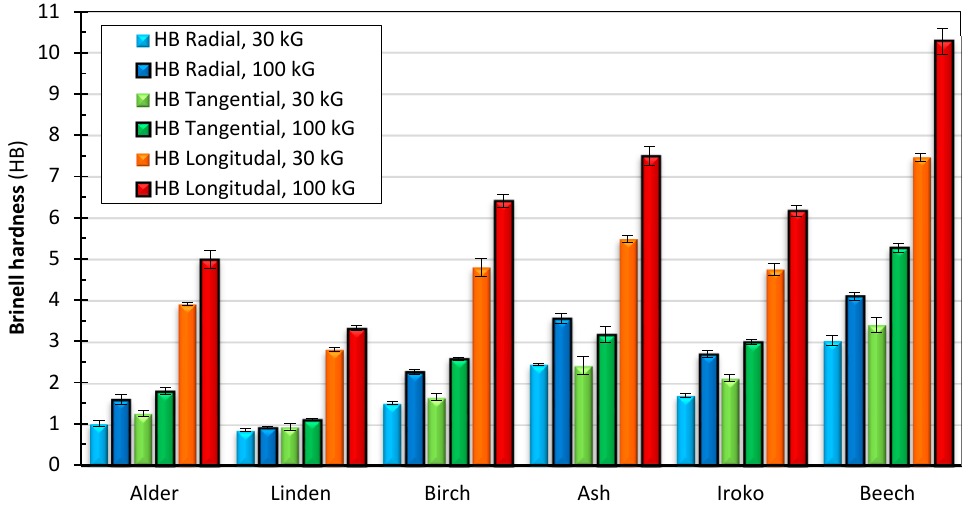
Figure 5. The Brinell hardness of the tested wood in the three main cross-sections of wood at two measuring forces (30 kG and 100 kG).